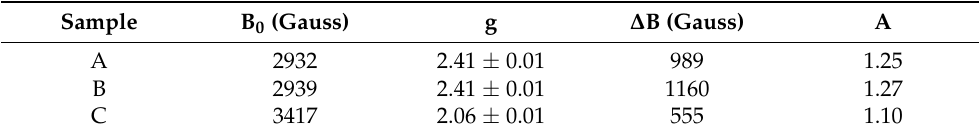
Figure 8. X-band EPR spectra measured for samples A, B and C at RT. Table 6. Summary of the parameters derived from the EPR spectra. B 0 induction magnetic field corresponding the resonance peak. g factor, ∆ B width of the peak. The asymmetry parameter A is defined as the ratio of the height of maximum to the depth of the minimum of the derivative of the